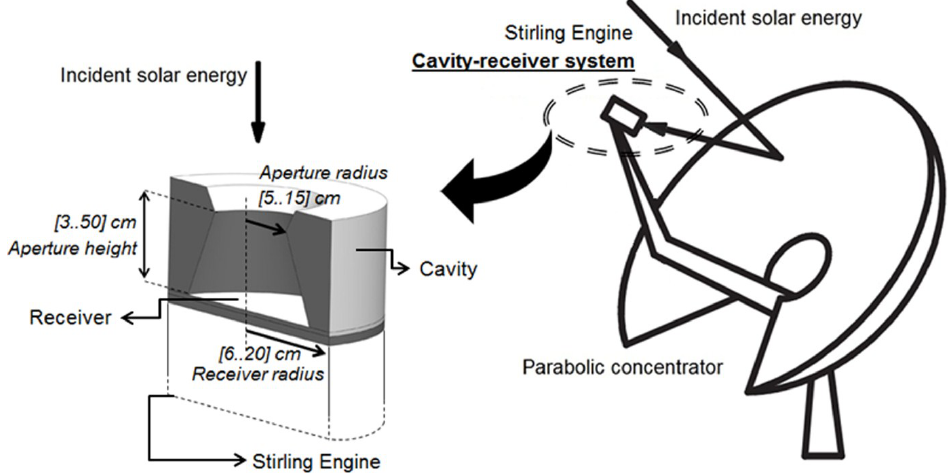
Figure 1. Modeled cavity geometry. Dish Stirling